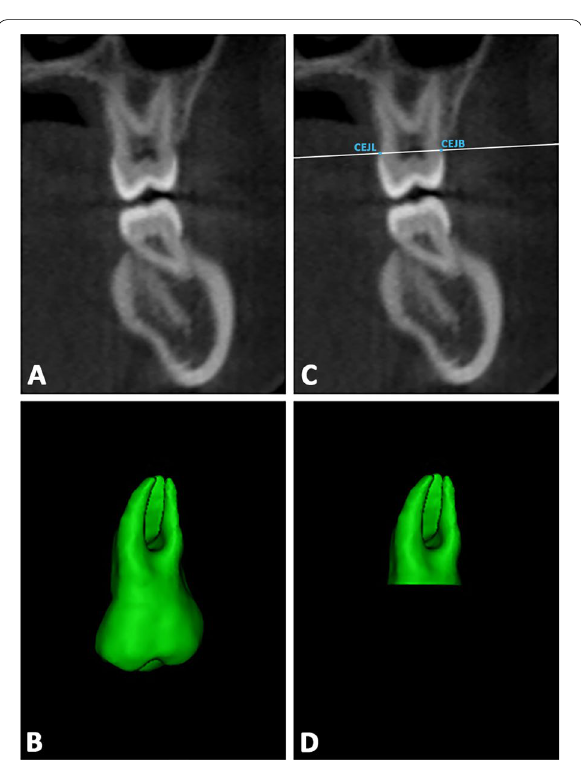
Fig. 3 a – b Definition of the plane cut passing through two landmarks placed on the midpoint of palatal and buccal aspects of the crown at the cementoenamel junction (CEJ) level; c – d generation of the radicular 3D model template for each tooth